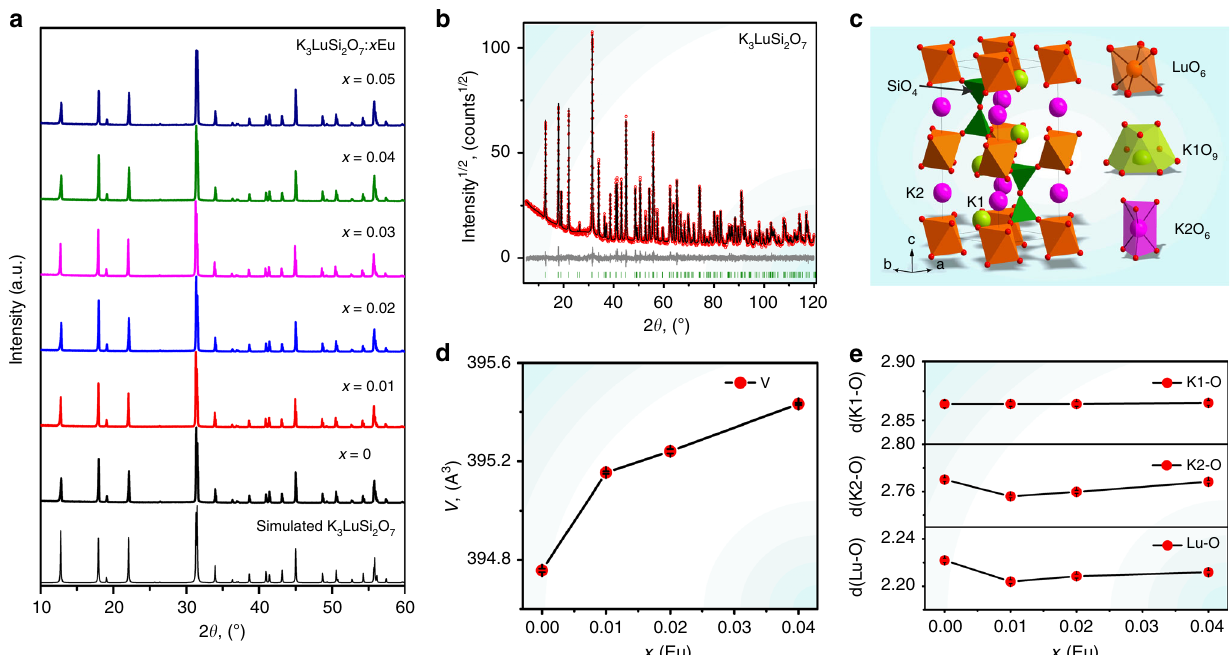
Fig. 1 XRD patterns and crystal/local structure descriptions of K 3 LuSi 2 O 7 :Eu. a Simulated and measured XRD patterns of K 3 LuSi 2 O 7 and K 3 LuSi 2 O 7 : x Eu 2 + ( x = 0.01 – 0.05). b Rietveld re fi nement and c crystal structure of K 3 LuSi 2 O 7 . d Cell volume V ( x ) dependence of the Eu doping concentration ( x = 0, 0.01, 0.02, 0.04). Small nonlinear trend can be associated with K → Eu replacement except for Lu → Eu substitution. e Dependence of the average bond length of Lu, K1, and K2 in K 3 LuSi 2 O 7 : x Eu 2 + ( x = 0, 0.01, 0.02,